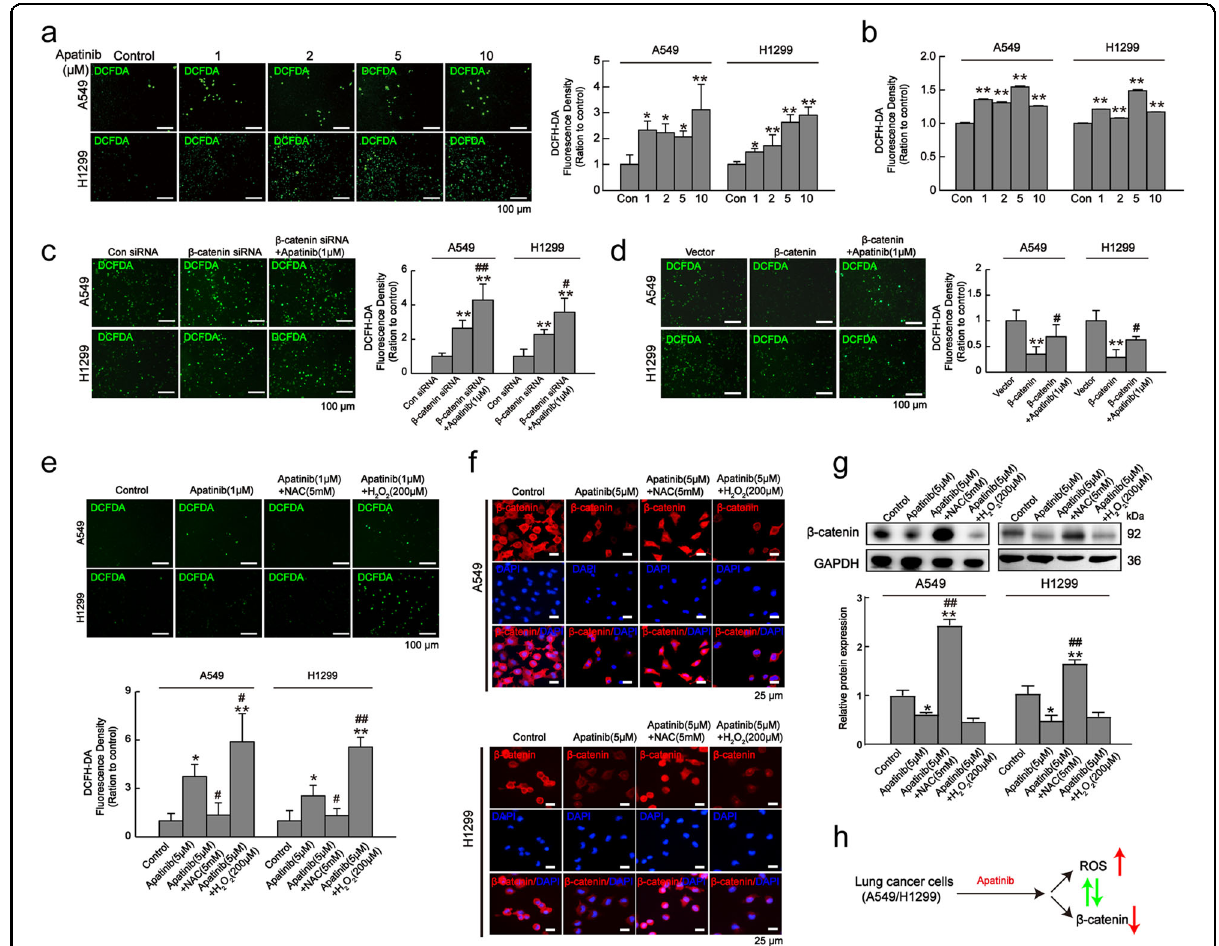
analysis of ROS in A549 and H1299 cells after various concentrations of apatinib treatment. Scale bar = 100 μ m. One-way ANOVA (Bonferroni ’ s multiple-comparison test) was used. Data are presented as mean ± SD ( n = 3). * p < 0.05, ** p < 0.01 compared to the control group. b Flow cytometry analysis of ROS. One-way ANOVA (Bonferroni ’ s multiple-comparison test) was used. Data are presented as mean ± SD ( n = 3). * p < 0.05, ** p < 0.01 compared with the control group. c Immuno fl uorescence analysis of ROS in β -catenin siRNA-transfected A549 and H1299 cells treated with or without apatinib (1 μ M) for 24 h. Scale bar = 100 μ m. One-way ANOVA (Bonferroni ’ s multiple-comparison test) was used. Data are presented as mean ± SD ( n = 3). ** p < 0.01 compared to the control group; # p < 0.05, ## p < 0.01 compared to the β -catenin siRNA group. d Immuno fl uorescence analysis of ROS in β -catenin-transfected cells treated with or without apatinib (1 μ M) for 24 h. Scale bar = 100 μ m. One-way ANOVA (Bonferroni ’ s multiple- comparison test) was used. Data are presented as mean ± SD ( n = 3). ** p < 0.01 compared to the control group; # p < 0.05 compared with the = β -catenin group. e Immuno fl uorescence analysis of ROS in apatinib-treated cells treated with 5 mM NAC or 200 μ M H 2 O 2 for 24 h. Scale bar 100 μ m. One-way ANOVA (Bonferroni ’ s multiple-comparison test) was used. Data are presented as mean ± SD ( n = 3). * p < 0.05, ** p < 0.01 compared to the control group; # p < 0.05, ## p < 0.01 compared to the apatinib (1 μ M) group. f Immuno fl uorescence analysis of β -catenin (red) expression in apatinib-treated cells with/without 5 mM NAC or 200 μ M H 2 O 2 for 24 h. DAPI: blue. Scale bar = 25 μ m. g Protein level of β -catenin in apatinib (5 μ M)- treated cells with/without 5 mM NAC or 200 μ M H 2 O 2 . One-way ANOVA (Bonferroni ’ s multiple-comparison test) was used. Data are presented as mean ± SD ( n = 3). * p < 0.05, ** p < 0.01 compared to the control group; ## p < 0.01 compared to the apatinib (5 μ M) group. h Schematic representation of the effect of apatinib on β -catenin and ROS in lung cancer